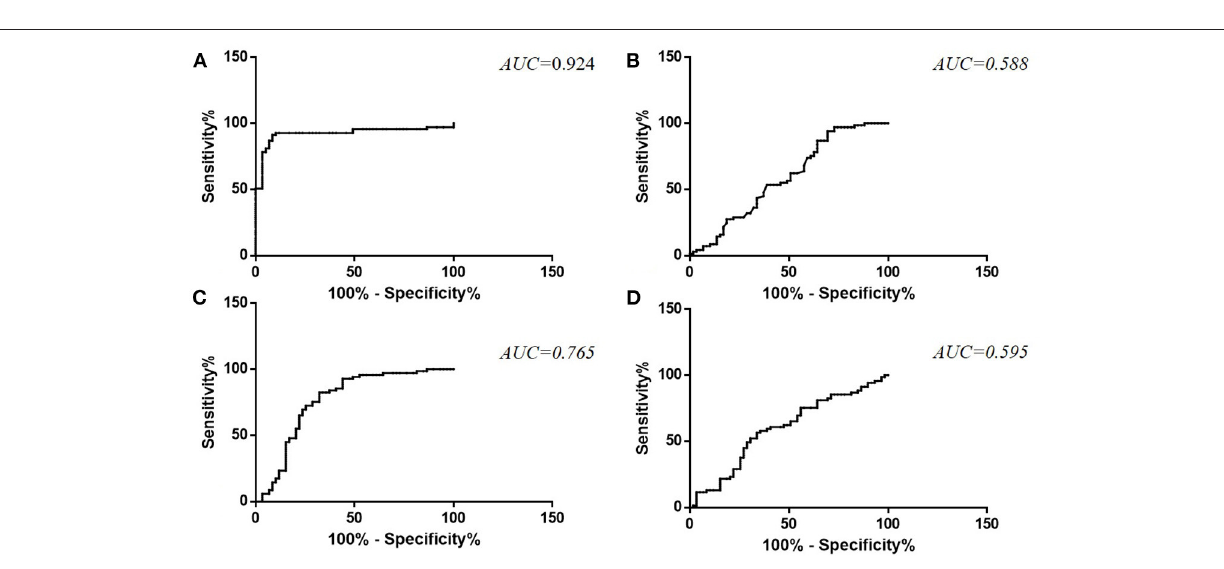
in plasma provided a 82.60% sensitivity and 67.80% specificity ( Figure 2C ). The optimal cut-off value for pTDP-43 levels in CSF (2.31%) provided a 56.50% sensitivity and 66.10% specificity ( Figure 2D ). In ALS patients, no significant difference was observed between males and females in TDP-43 (plasma: P = 0.410, CSF: P = 0.462) and pTDP-43 (plasma: P = 0.223, CSF: